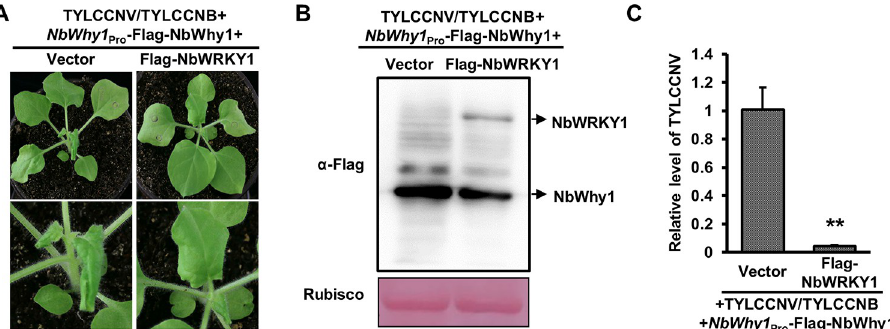
Fig 6. NbWRKY1 enhances plant defense against TYLCCNV/TYLCCCNB by repressing NbWhy1. (A) Symptoms induced by TYLCCNV/TYLCCNB in N . benthamiana plants inoculated with TYLCCNV/TYLCCNB+ NbWhy1 Pro - Flag-NbWhy1+Flag-NbWRKY1 or TYLCCNV/TYLCCNB+ NbWhy1 Pro -Flag-NbWhy1+pCambia-Flag (Vector) at 5 dpi. (B) Western blot analysis of the expression of Flag-NbWhy1 and Flag-NbWRKY1 in the infiltrated leaf samples at 48 hpi. Ponceau staining of Rubisco serves as a loading control. (C) qPCR analysis of the relative accumulation of TYLCCNV DNA in the plants shown in (A). 25S rRNA was used as an internal control. Mean and standard deviation of three independent plants are shown. Double asterisks indicates a significant statistical difference between two treatments at p < 0.01 based on Student’s t test.